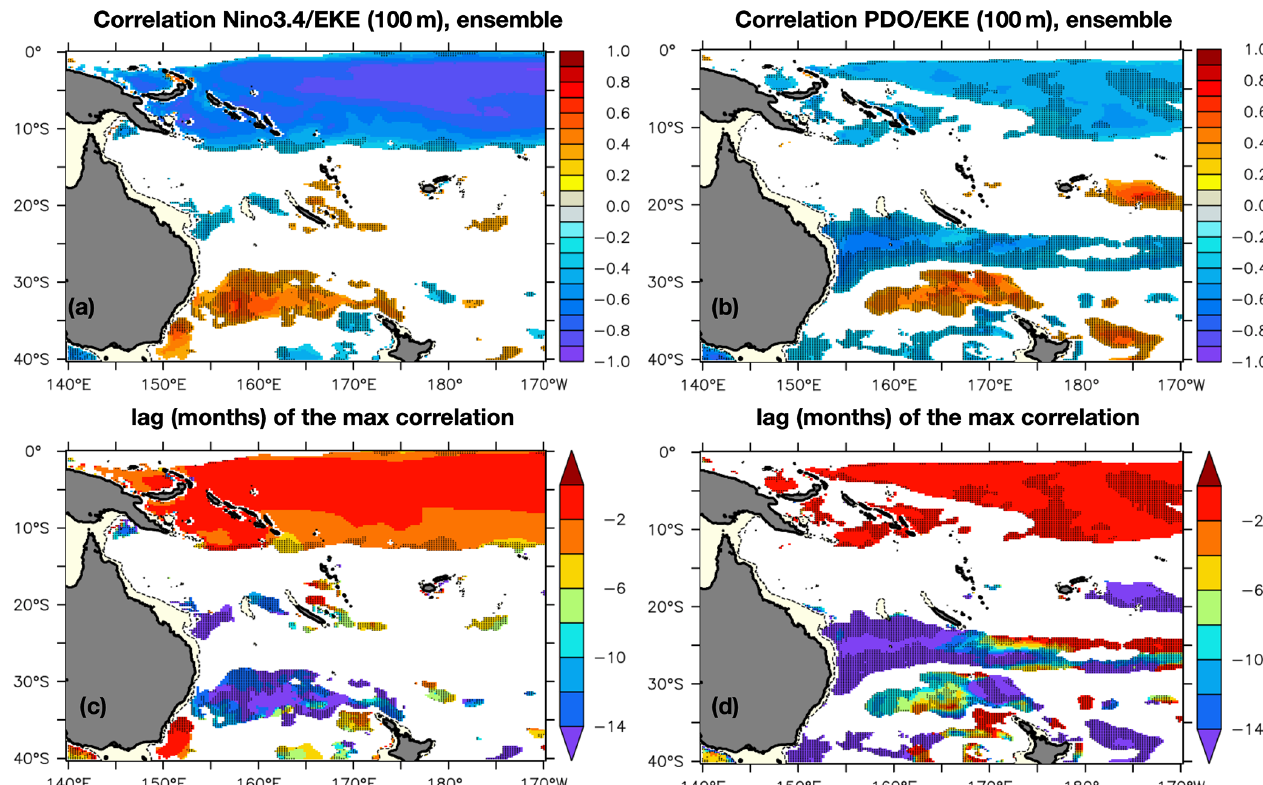
Figure 8. Maximum lagged correlation (a) and corresponding lag in months (taken between − 18 and 0 months) (c) between the Nino3.4 index and the 100m EKE interannual variations for the ensemble. Only significant correlations are plotted. A negative lag means that Nino3.4 leads the EKE variations. (b, d) Same as (a, c) for the PDO index. In all panels, the hatched areas show regions where the same maximum lagged correlation for 100m EKE interannual variations in one member picked randomly (member 39) is not